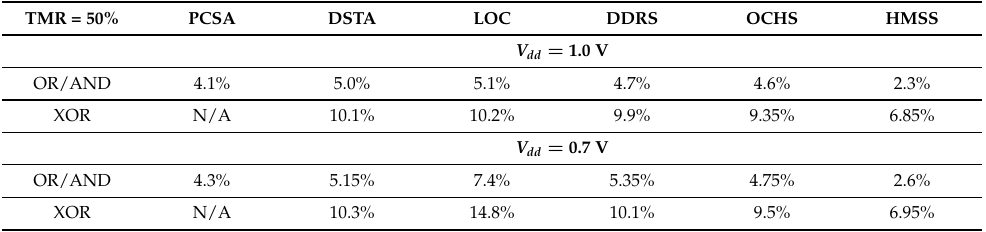
Table 4. The failure probability of LIM bit-wise operation with low